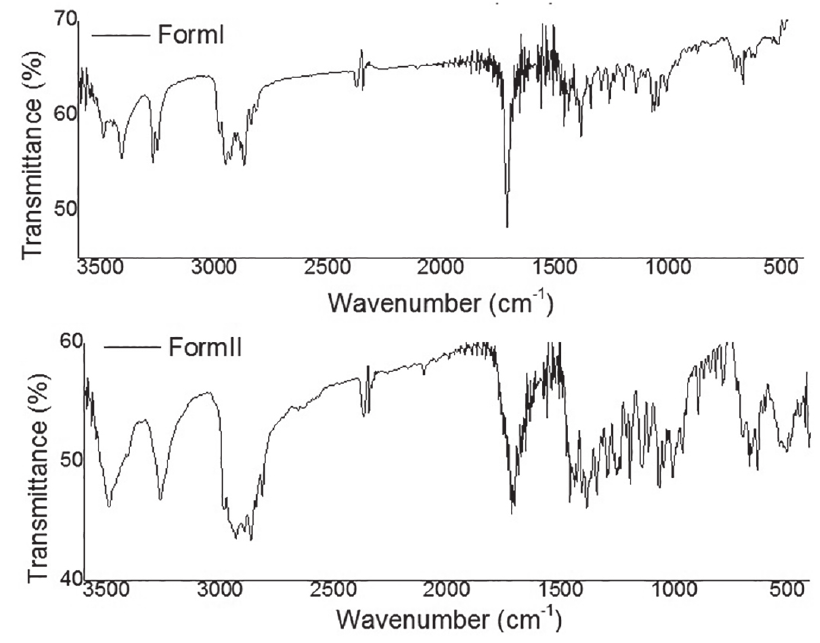
FIGURE 3 - Experimental FTIR-ATR spectra of tibolone forms I and II.